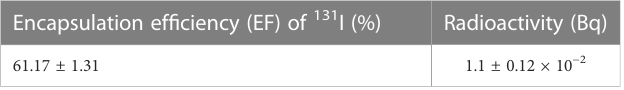
FIGURE 3 The diameter and radiochemical purity of 131 I-PLGA-rhTSH nanoparticles. (A) The diameter of the 131 I-PLGA-rhTSH nanoparticles. (B) The radiochemical purity in PBS at 10 h, 20 h, and 30 h. (C) The radiochemical purity of serum at 10 h, 20 h, and 30 h.